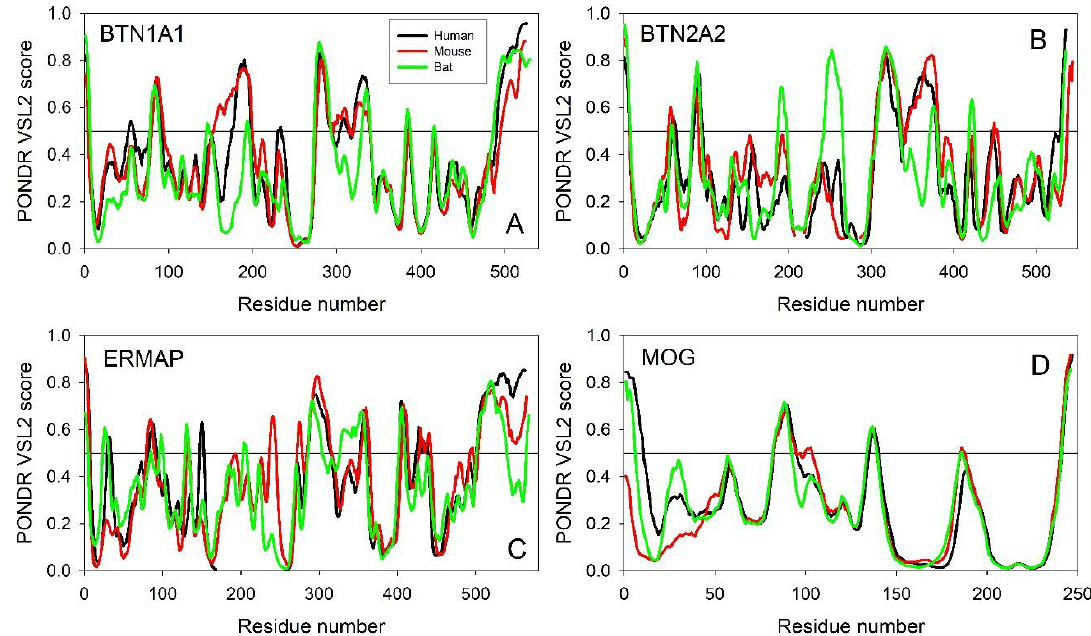
Figure 3. Evolutionary conservation of the peculiarities of intrinsic disorder predisposition in butyrophilins as evaluated by PONDR ® VSL2. ( A ) BTN1A1. ( B ) BTN2A2. ( C ) ERMAP. ( D ) MOG. Results for proteins from human, mouse, and Tasmanian devil are shown by black, red, and green lines, respectively. A disorder threshold is indicated as a thin line (at score = 0.5) in all plots to show a boundary between disorder (>0.5) and order (<0.5).